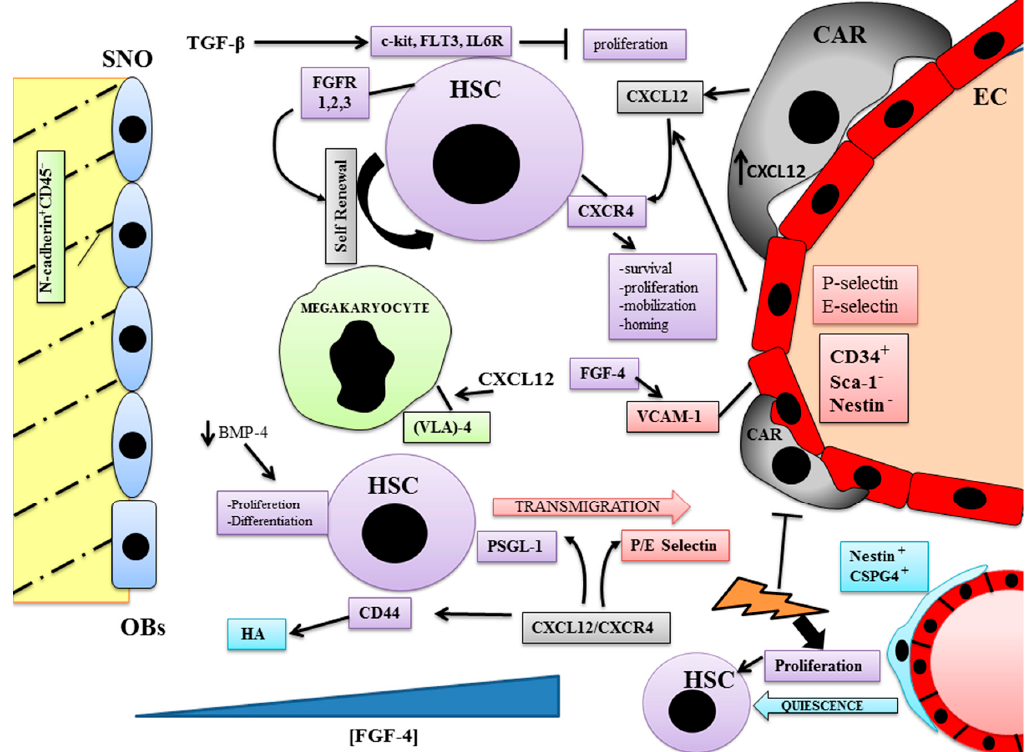
Figure 2. In the vascular niche hematopoiesis occurs in the extravascular spaces between the sinuses. The medullary vascular sinuses are lined with endothelial cells and surrounded by adventitial cells, called CXCL12-abundant reticular (CAR) cells. The closeness between sinusoidal endothelial cells and HSCs is very important for their maturation and so for the hematopoietic process. An arteriolar niche has been found where quiescent HSCs are associated with a cell population different from CAR, named peri-arteriolar nestin cells. These cells express chondroitin sulfate proteoglycan-4 (CSPG4), show chemoresistance after genotoxix injury, and activate HSC proliferation. CXCL12-abundant reticular cells (CAR); fibroblast growth factor receptors (FGFRs); transforming growth factor- β (TGF- β ); bone morphogenetic protein (BMP); hyaluronic acid (HA); glycoprotein ligand-1 (PSGL-1); very late antigen (VLA-4); chondroitin sulfate proteoglycan-4 (CSPG4); fibroblast growth factor-4 (FGF-4); P/E selectin type P and E (P/E selectin); vascular cell adhesion molecule 1 (VCAM-1); FMS like tyrosine kinase 3 (FLT3); interleukin 6 receptor (IL6R). Blue triangle: FGF-4 gradient; lightning sign: genotoxic stimulation.